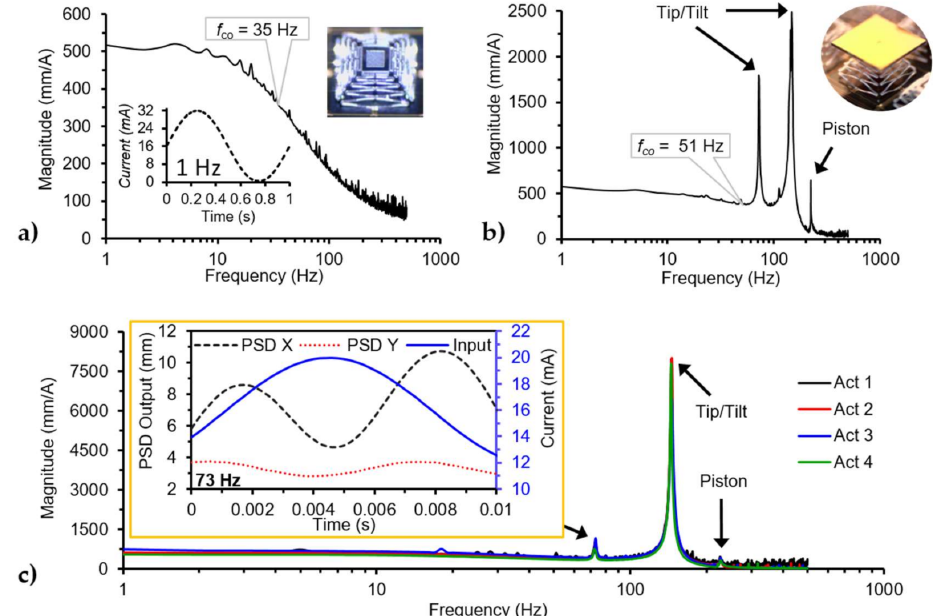
Figure 9. Frequency response for the undercarriage and mirror-bonded devices under single actuator bias. ( a ) Magnitude bode plot for the undercarriage with an inset of the input signal with a maximum value of 32 mA and another with an optical image of the undercarriage, ( b ) magnitude bode plot for the mirror-bonded device by applying an input current with a maximum value of 32 mA an inset of an optical mirror-bonded device, ( c ) magnitude bode plot for the mirror-bonded with an input current magnitude of 8 mA with an inset showing the input/output plot for 73 Hz, where the input and output frequencies were at 73 and ~145 Hz,